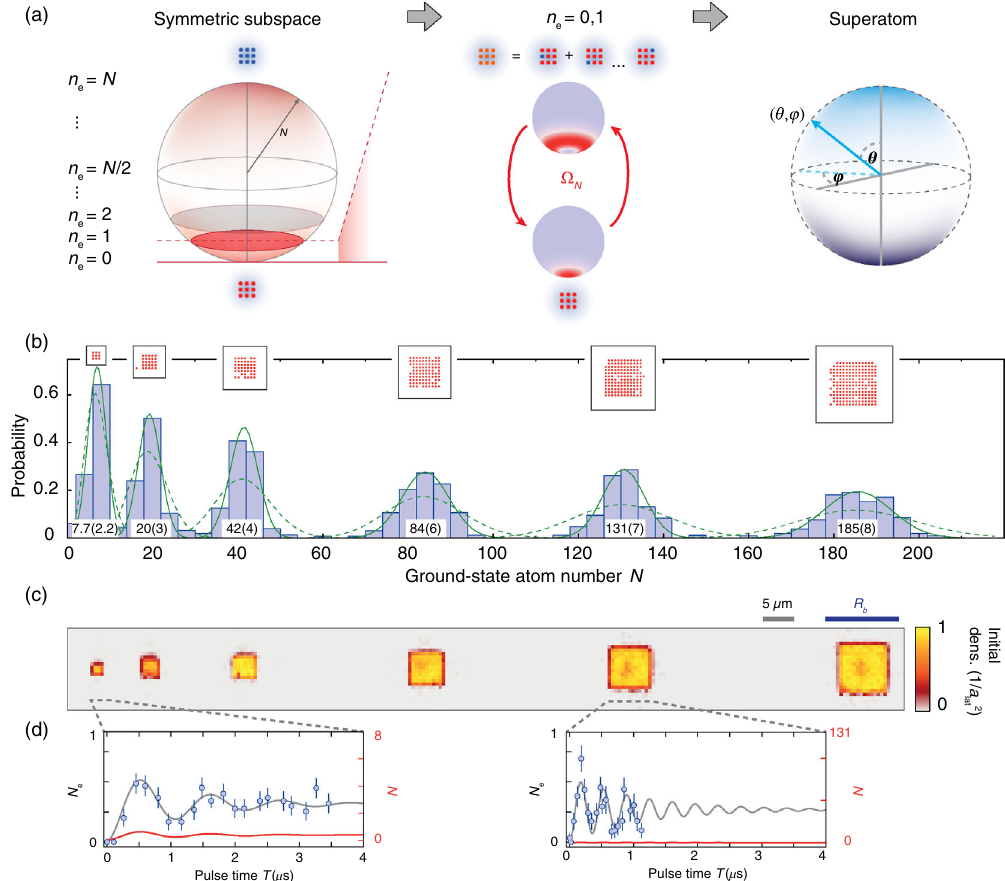
FIG. 1. Superatom preparation. (a) Illustration of the symmetric ground and singly excited state ( W state). Left: N -atom collective ¼ 0 ) and singly Bloch sphere with its basis states (labeled by excitation numbers n ) and coupled states highlighted [south pole ( n e e ¼ 1 ), represented by the red plane]. The small pictograms above and below the sphere depict the lattice system with excited state ( n e atoms in the ground (red) and Rydberg (blue) states. The dashed red line indicates a zoom into the subspace spanned by the lowest two states. The Husimi distribution of these states and their enhanced coupling Ω is shown in the center. This accessible state space defines N a superatom represented by the standard Bloch sphere on the right. (b) Atom-number histograms of the initially prepared samples (blue bars) with Gaussian fits (solid green line). The numbers give the mean and standard deviation for each data set. Measured and reconstructed occupation of lattice for exemplary initial states is depicted above the respective histograms; see the schematic pictograms in (a). The Poissonian distribution with the same mean atom number is shown as a reference (dashed green line). (c) Averaged initial ground-state atom distributions for the respective histograms above. The size of blockade radius R is shown by the blue bar. (d) Rabi b oscillation data (blue points) and sinusoidal fits with exponentially decaying contrast (solid gray line) for N ¼ 7 . 7 ð 2 . 2 Þ and N ¼ 131 ð 7 Þ . The red line shows the same fit on an axis scaled to the number of ground-state atoms N (right axis). All error bars denote the standard error of the mean